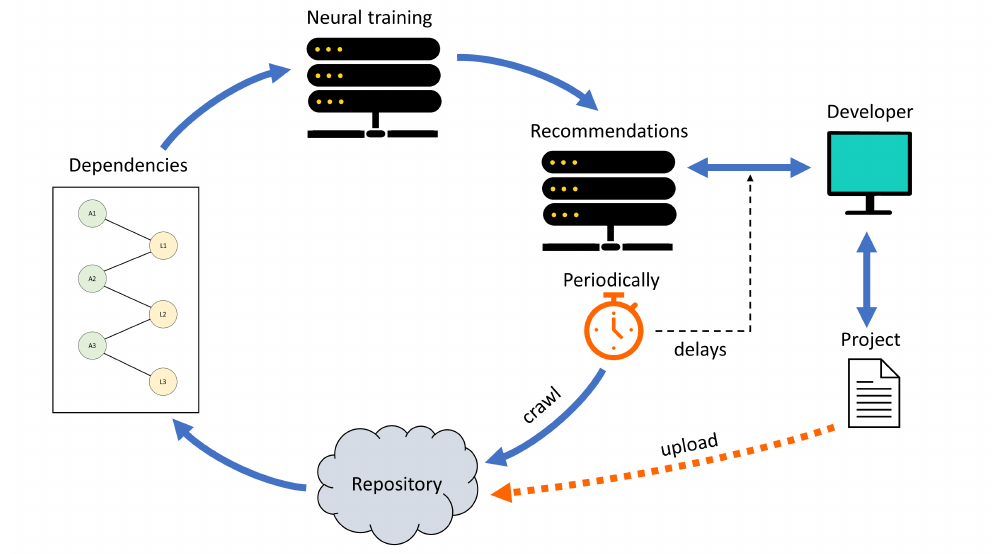
Figure 1. Integrating neural solutions in library recommendation pipelines. Periodic crawling of code repositories integrates uploaded projects in neural training, thus delaying developers from accessing recommendations for these